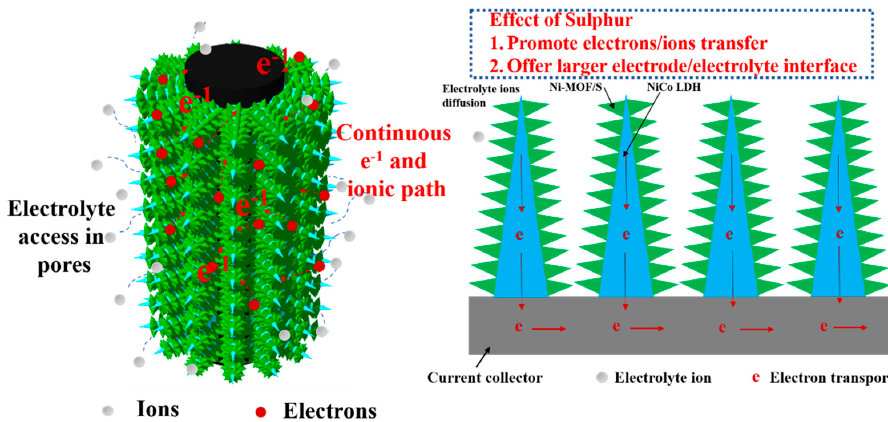
Figure 6. Schematic illustration of the electron and ion transport in the LDH/Ni-MOF/S